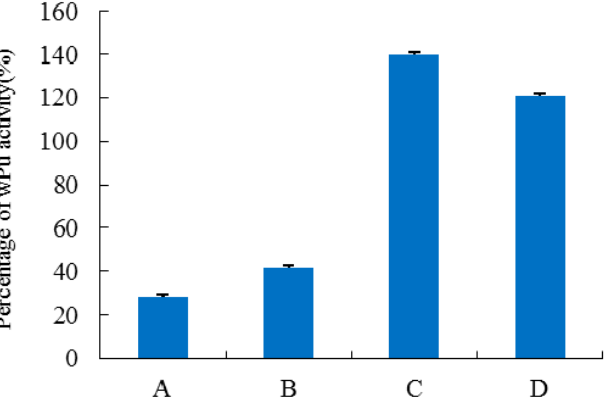
Figure 6. Specific activity determined for mutants obtained by site-directed mutagenesis. Values are expressed as a percentage of the specific activity observed for wPU. ( n = 5, error bars represent standard deviation). (A) H 1-2 P 3 H 4 P 5-6 H 7-8 ; (B) H 1-2 P 3 H 4 P 5-6 H 7-8 (E24D); (C) H 1-2 P 3 H 4 P 5-6 H 7-8 (E24D & E83G); (D) PBC.